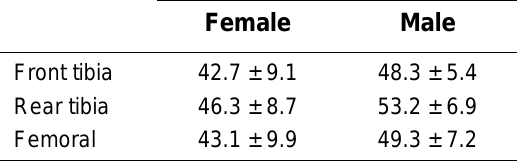
Mean Diameter Values of Rabbit Collagen Fibrils from Various Bone